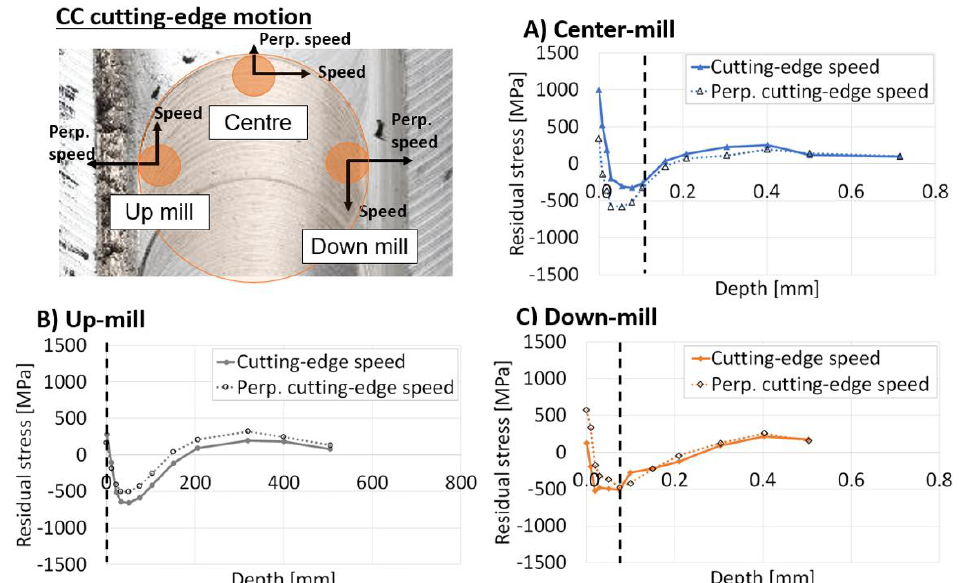
Figure 8. Residual stress profiles from surfaces subsequently machined first with ceramic milling followed by 50 µm step with a new cemented carbide tool (CC) at different positions across the slot.